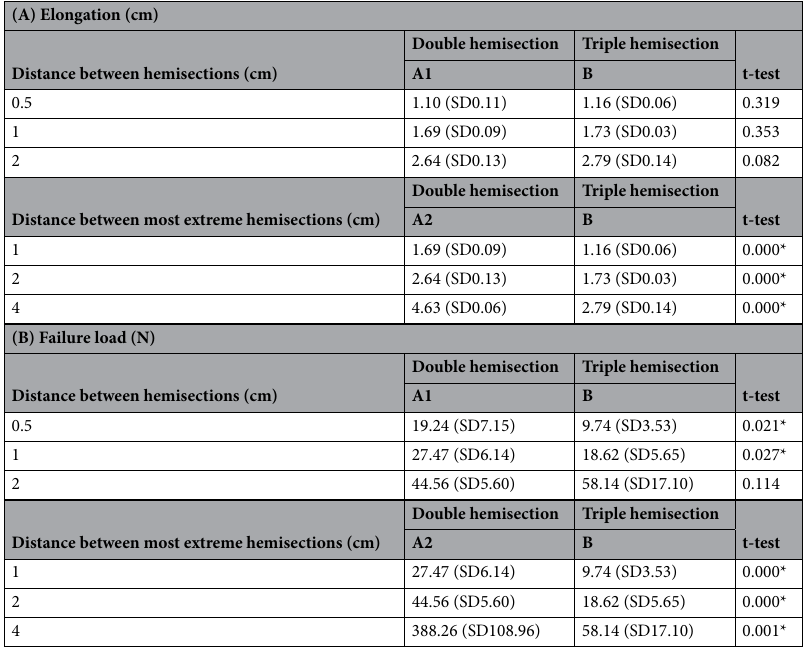
Table 1. The elongations and failure loads with different distances between hemisections and between the most extreme hemisections in the double- and triple-hemisection groups. (A) *P < 0.05. Elongation of tendons in the double-hemisection group was significantly higher than that in the triple-hemisection group when the distance between the most extreme hemisections was 1 cm, 2 cm or 4 cm. (B) *P < 0.05.: Failure load of tendons in the double-hemisection group was significantly higher than that in the triple-hemisection group when the distance between hemisections was 0.5 cm or 1 cm, or the distance between the most extreme hemisections was 1 cm, 2 cm or 4